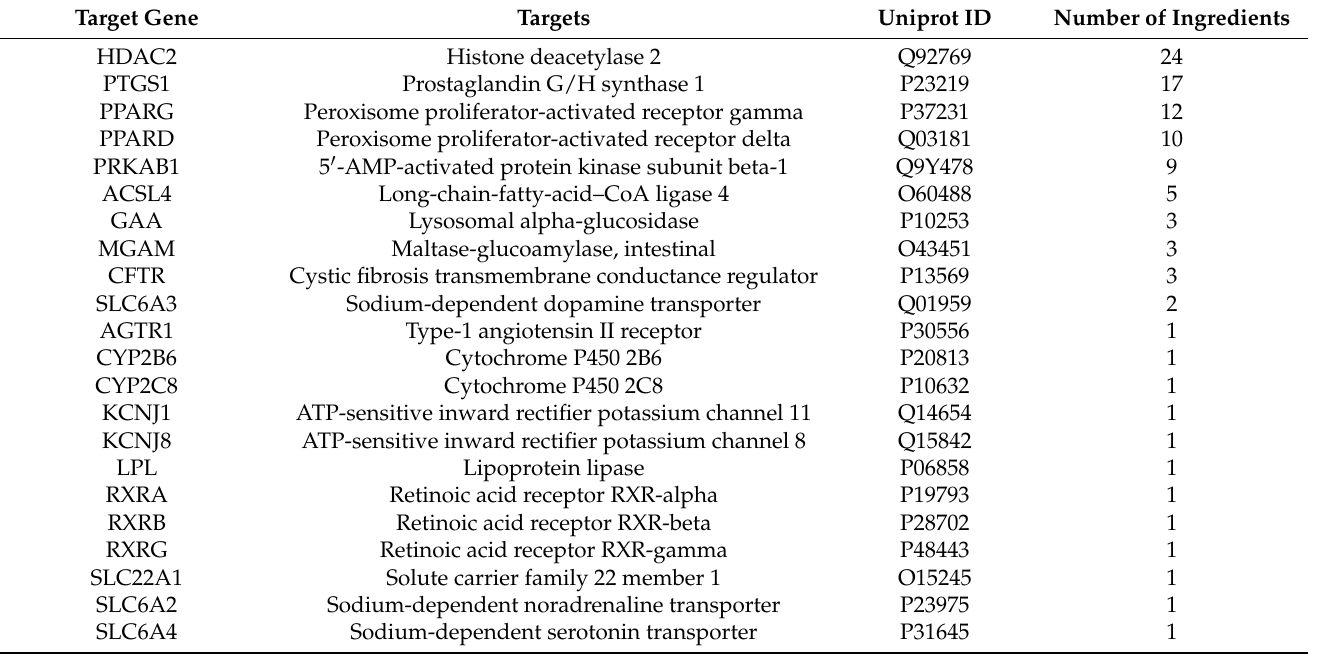
Table 2. The potential hypoglycemic targets of Scutellariae